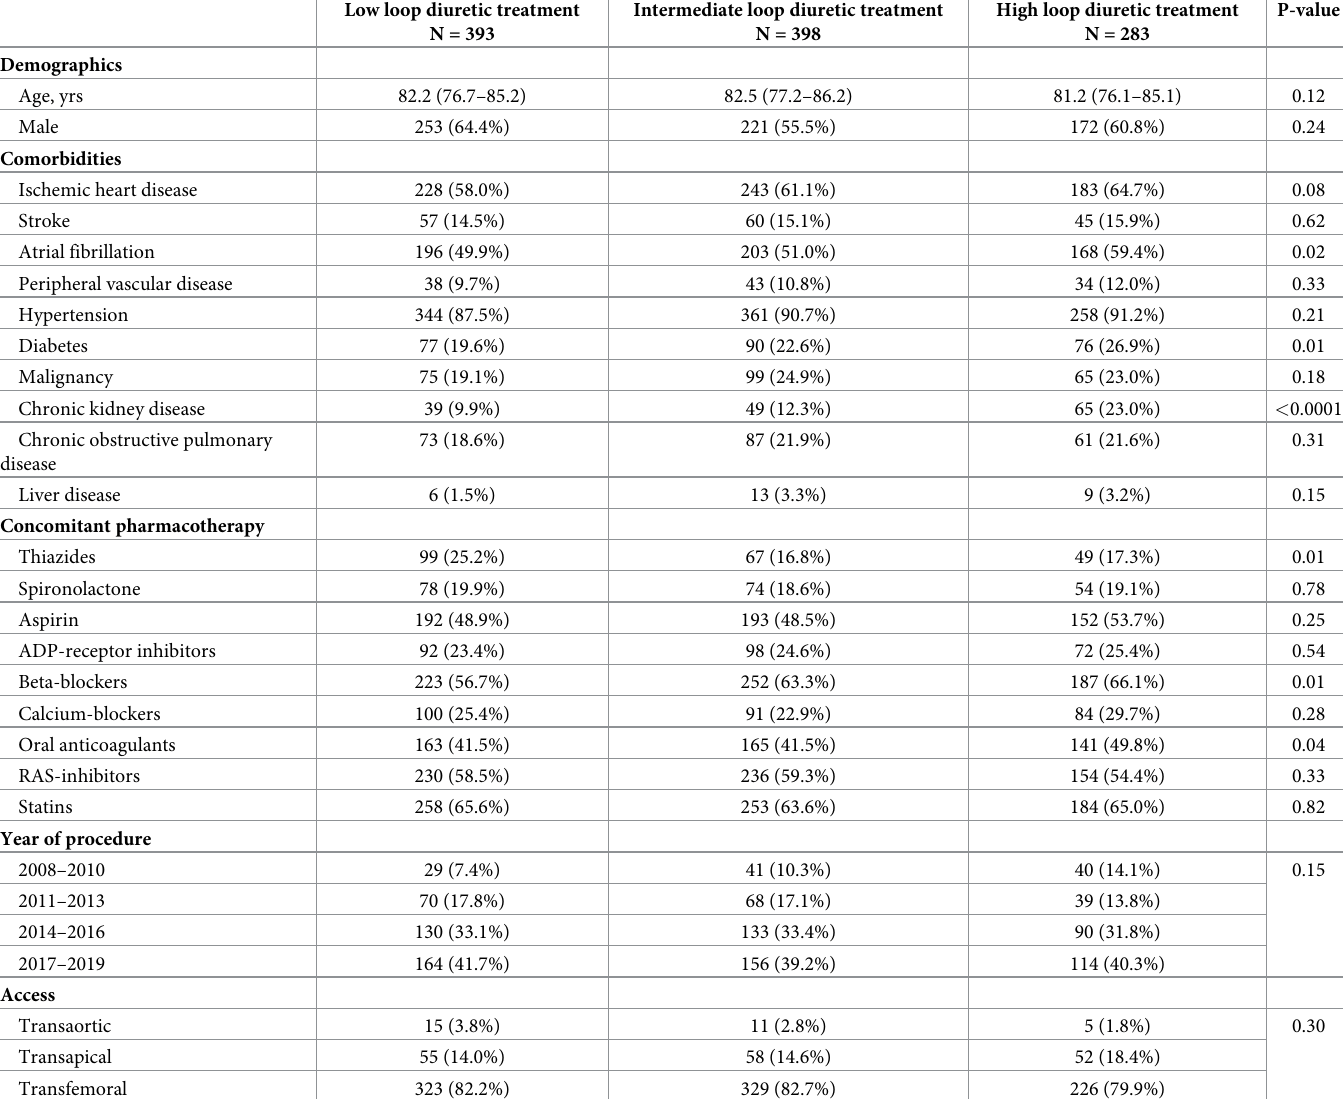
Table 3. Baseline characteristics of patients with a medical history with heart failure and loop diuretic treatment at